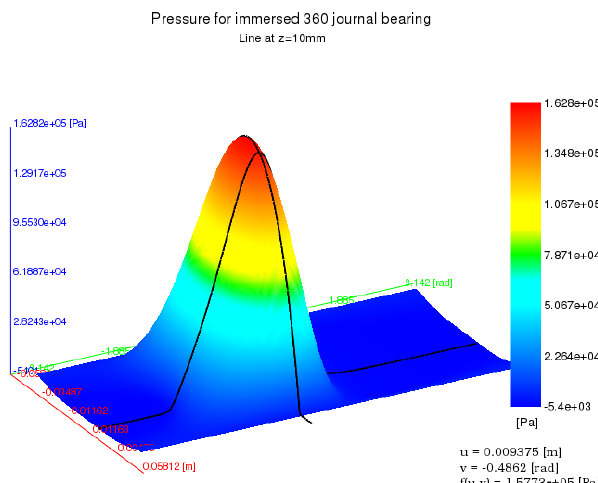
Figure 7: Pressure distribution after transient simula- tion of 3 revolutions, for dispersed air cavi- tation model, with Dowson-Higginson (DH) pure oil compressibility combined with gas compressibility (10% at p = 0), and elastic surfaces. Markers outline the location z = 10 mm.